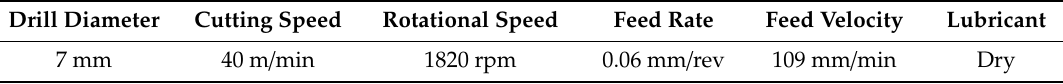
Table 1. Drilling parameters used in the present study.